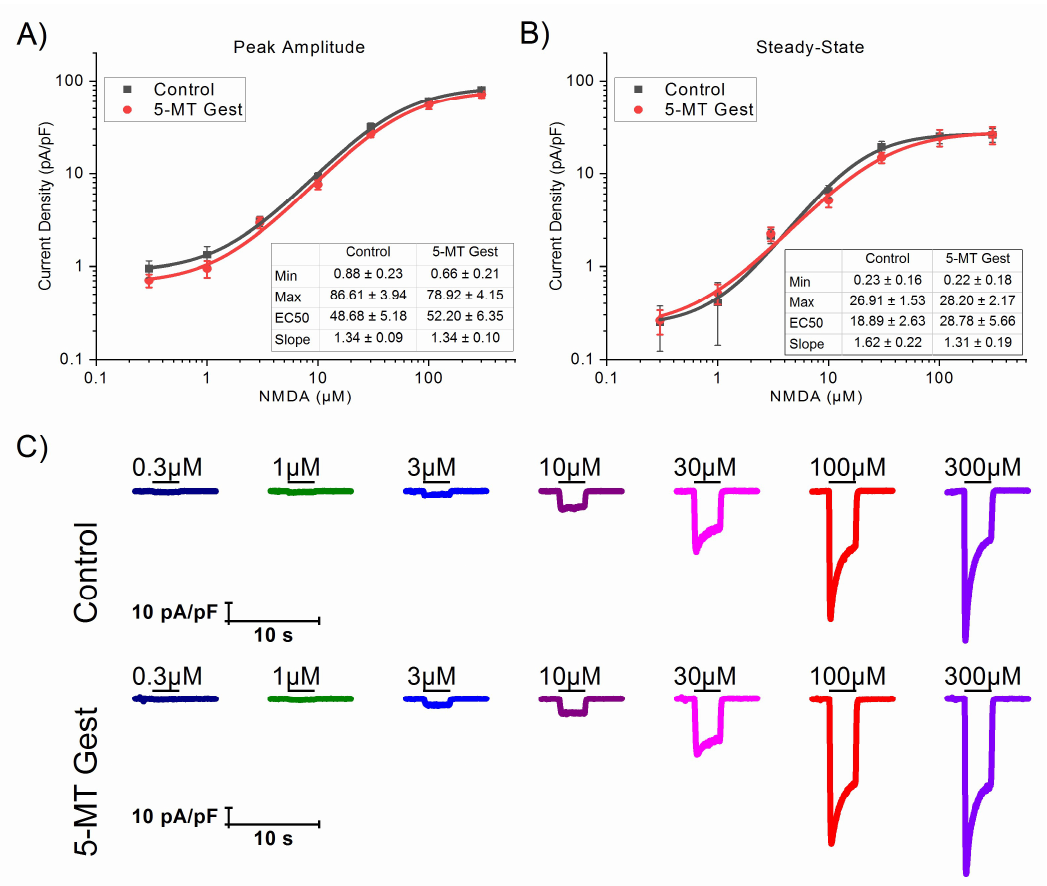
Figure 5. NMDA dose-response curve from 0.3 to 300 µ M in both groups. We analyzed the peak amplitude ( A ) and SS ( B ) of currents from each concentration, then fitted the data with a logistic function (solid lines) and compared the fitting curves with an F-test. No significant di ff erences were found between groups (peak amplitude: F 4,119 = 1.98, p = 0.10; SS: F 4,119 = 0.99, p = 0.42). ( C ) Representative traces of I NMDA for each tested concentration on both groups. Table 2. Peak amplitude and steady-state of currents from each NMDA concentration.